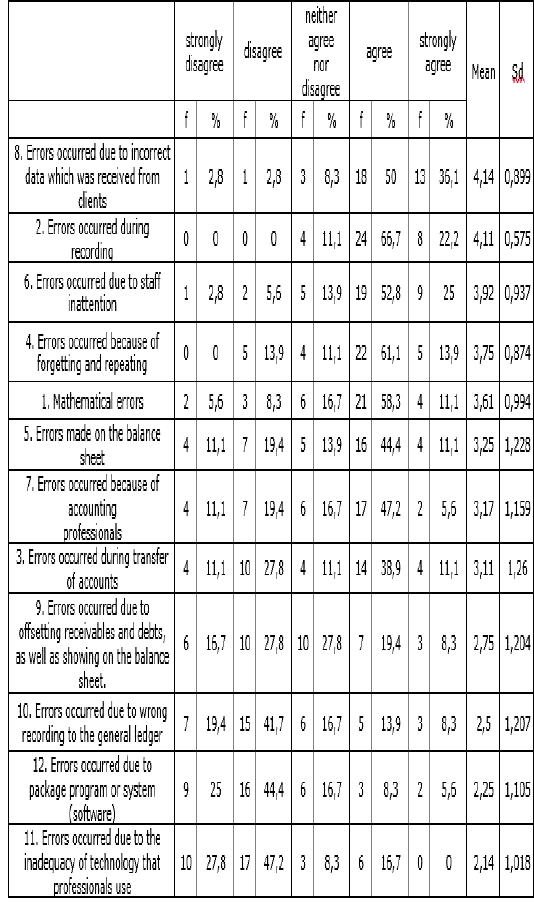
Table 15: Frequency Distribution for Error